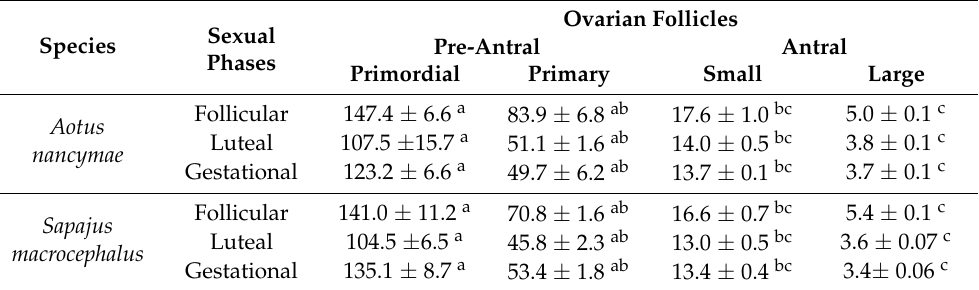
Table 2. Quantification of the ovaries of Ma’s night monkeys ( Aotus nancymae , n = 6) and large-head capuchins ( Sapajus macrocephalus , n = 6) according to the sexual phase.